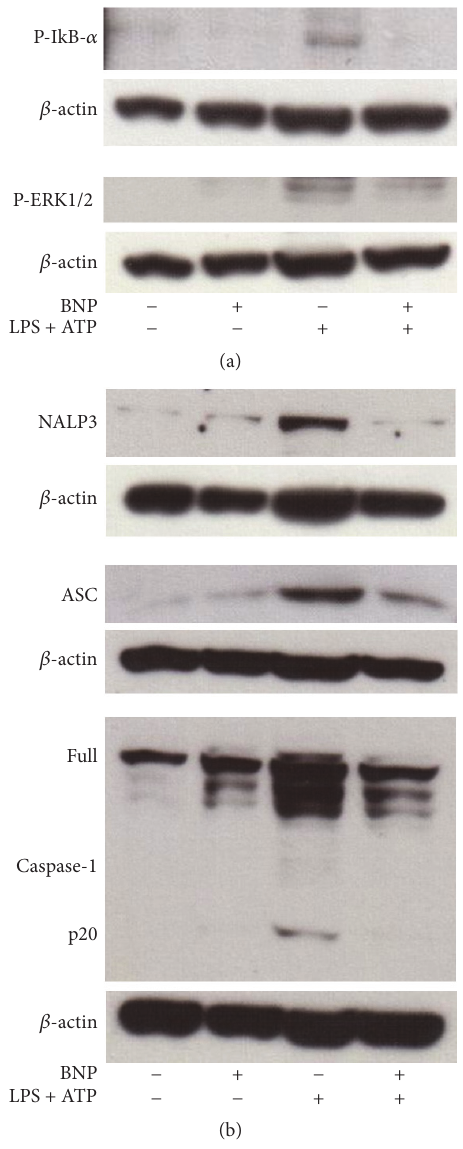
Figure 6: BNP is involved all the molecular mechanisms con- trolling IL-1 𝛽 production and release by inhibiting the activa- tion of NF-kB, ERK 1/2 and of all the elements of NALP3 inflammasome/ASC/Caspase-1 cascade in macrophage-like cells. PMA differentiated THP-1 cells were treated with 10 −8 M BNP in absence or presence of 10 𝜇 g/mL LPS/5 mM ATP for 30 min. Cell lysates were immunoblotted for P-IkB- 𝛼 and P-ERK1/2 (a) or NALP3, ASC, or Caspase-1 (b). The blots were stripped of the bound Ab and reprobed with mouse anti- 𝛽 -actin, to confirm equal loading. Western blots are representative of three separate